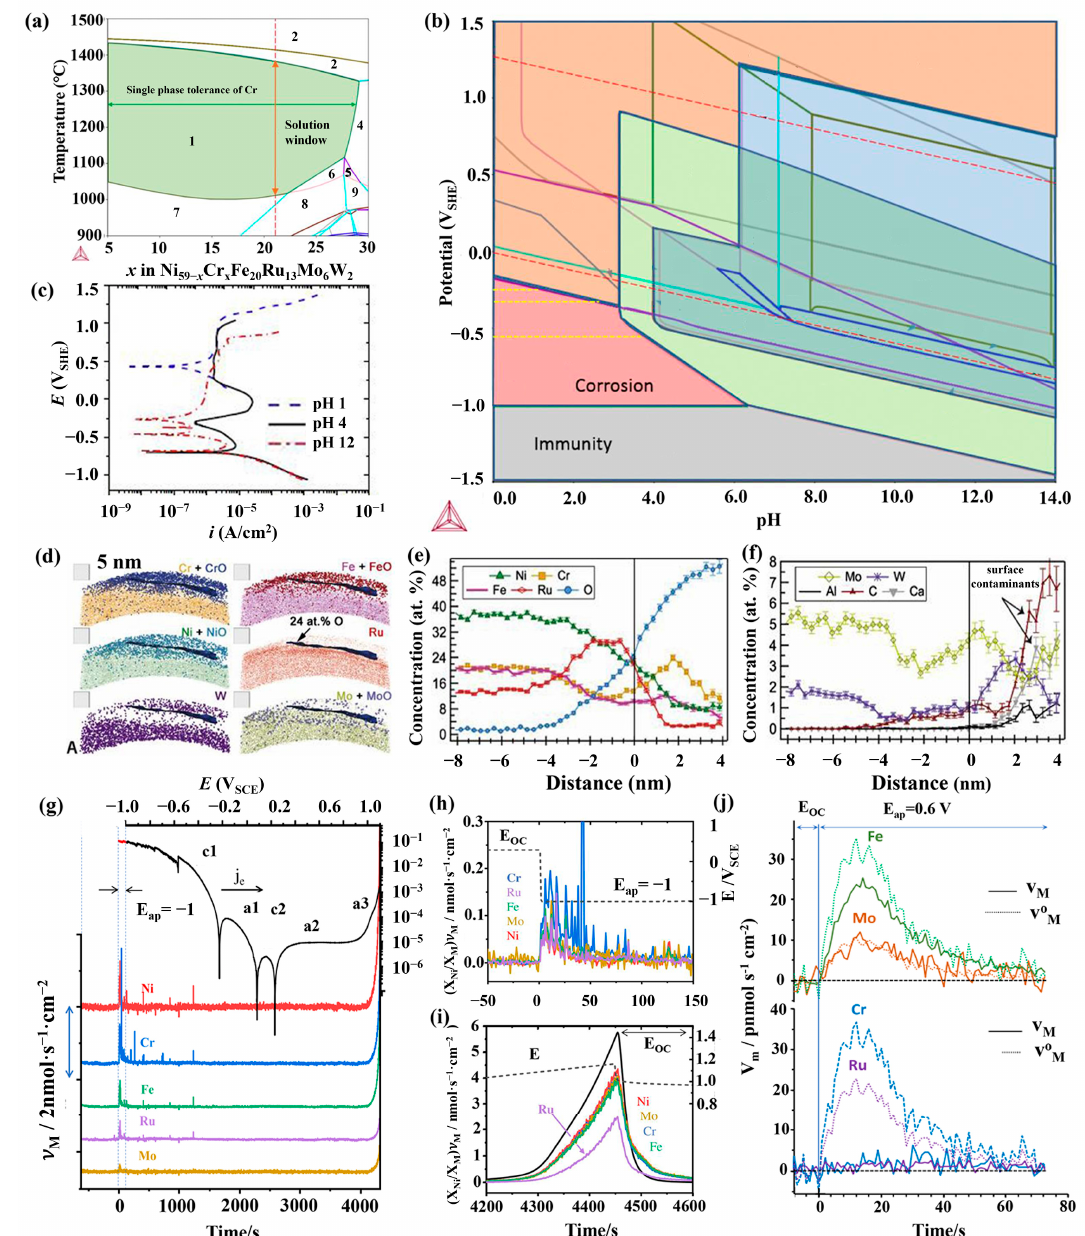
Figure 7. The design of corrosion resistant HEAs by using integrated computational materials engineering (ICME), and corresponding characterizations of the film chemistry and electrochemical behaviors. ( a ) Pseudo-binary phase diagram of the Ni 59 − x Cr x Fe 20 Ru 13 Mo 6 W 2 alloy system; ( b ) CALPHAD-calculated E -pH plots for Ni 38 Cr 21 Fe 20 Ru 13 Mo 6 W 2 in 1 kg H 2 O at 25 °C and 1 atm.; ( c ) potentiodynamic polarization curve of the Ni 38 Cr 21 Fe 20 Ru 13 Mo 6 W 2 HEA in 0.1 M Na 2 SO 4 solution with different pH; ( d – f ) APT characterization of the passive film formed on the HEA; ( g – i ) the polarization curve (upper) and the elemental dissolution rates (lower) of the HEA in de-aerated 2 M H 2 SO 4 ; ( j ) elemental dissolution rates during a potentiostatic polarization at 0.6 V SCE [63–65].